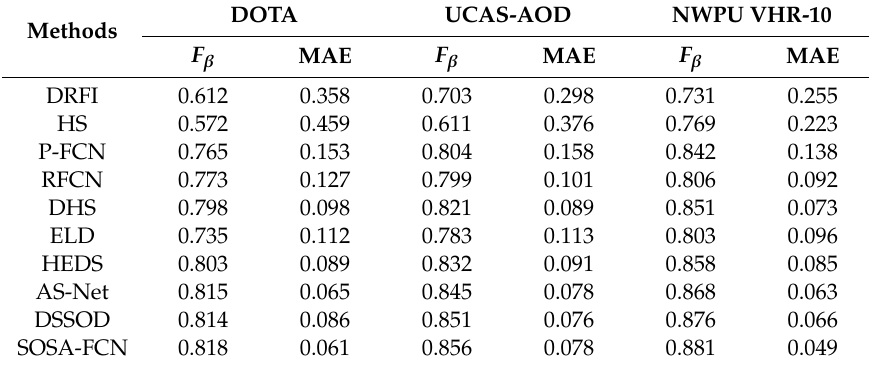
Table 2. The F β and mean absolute error (MAE) scores of salient object detection (SOD) for di ff erent datasets.